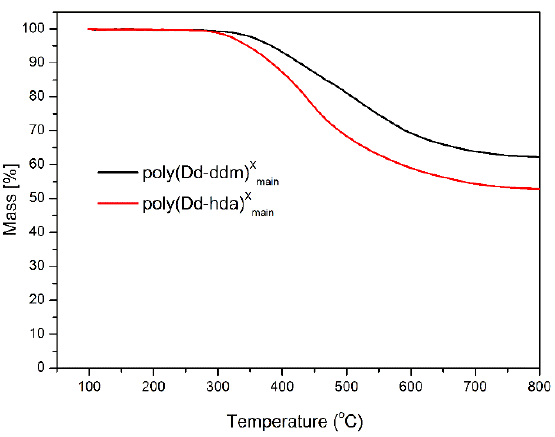
Figure 6. Thermogravimetric analysis of poly(Dd-hda) Xmain and poly(Dd-ddm) Xmain under N 2 .